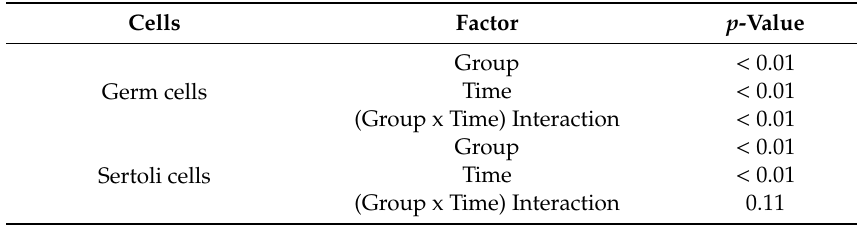
Table 3. Results from 2-way analysis of variance for testing the influence of group, time and their interaction on either germ or Sertoli cell counts. Cells Factor p -Value